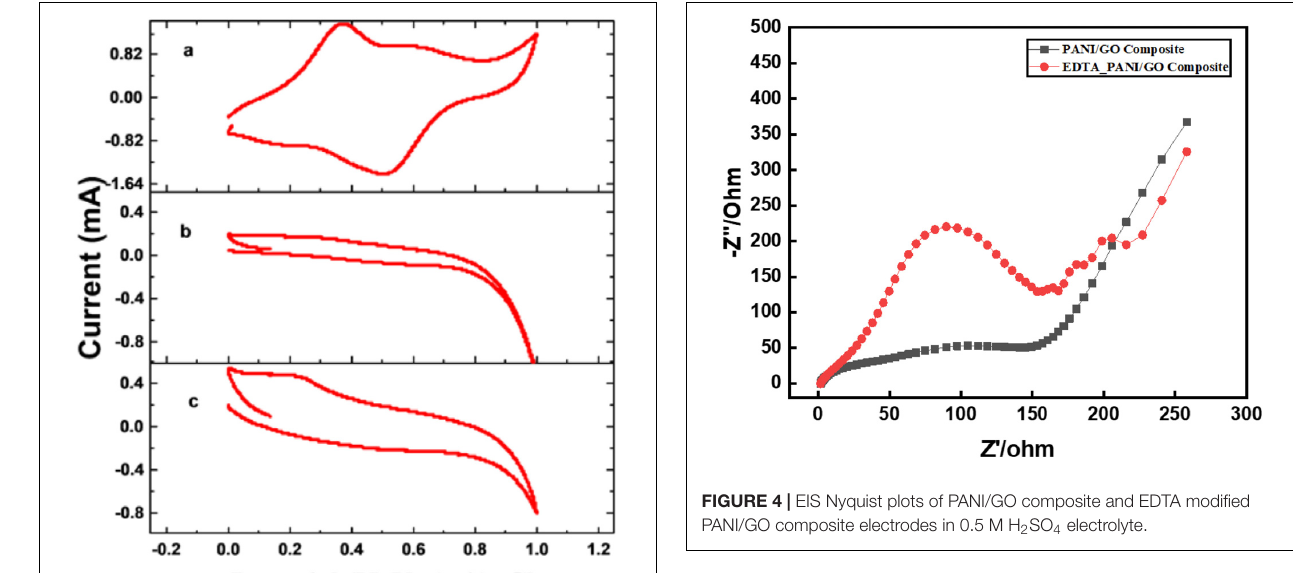
FIGURE 3 | Cyclic voltammogram of (A) PANI, (B) PANI/GO composite, and (C) EDTA modified PANI/GO composite electrodes in 0.5 M H 2 SO 4 electrolyte.